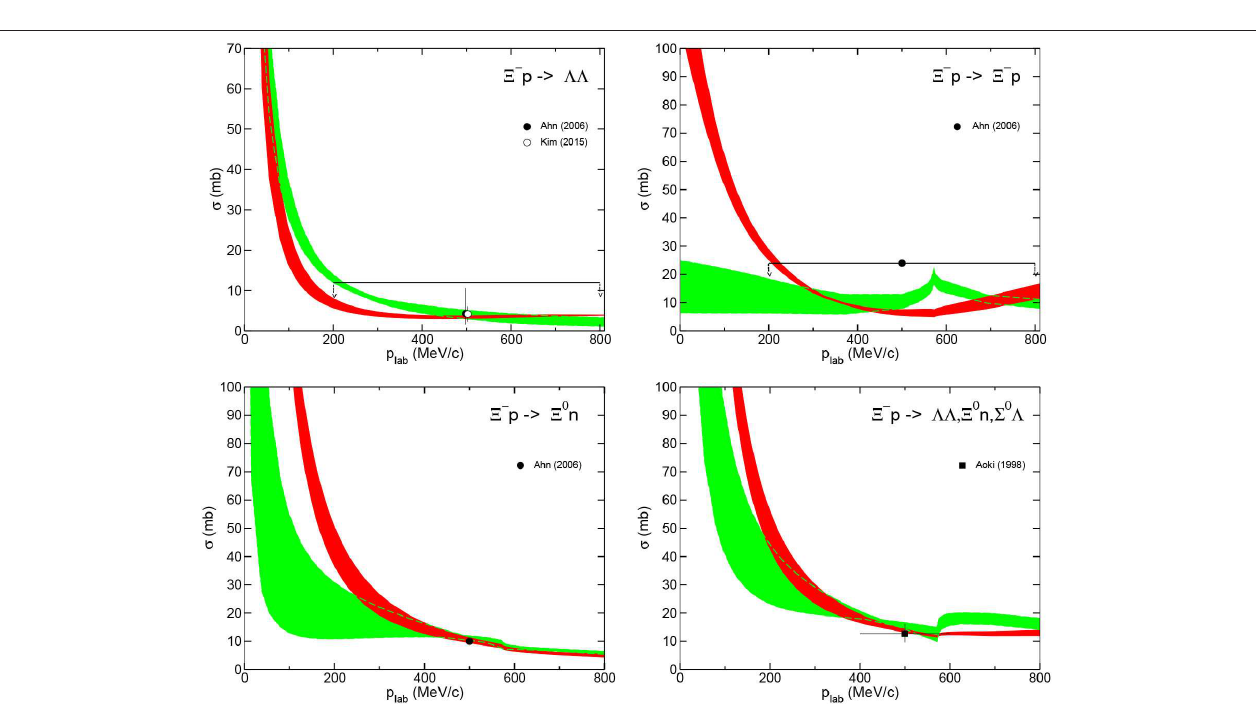
FIGURE 15 | 4 − p induced cross sections. The bands represent results at NLO (red/black) [36] and LO (green/gray) [30]. Experiments are from Ahn et al. [178], Kim et al. [unpublished data], and Aoki et al. [177]. Upper limits are indicated by